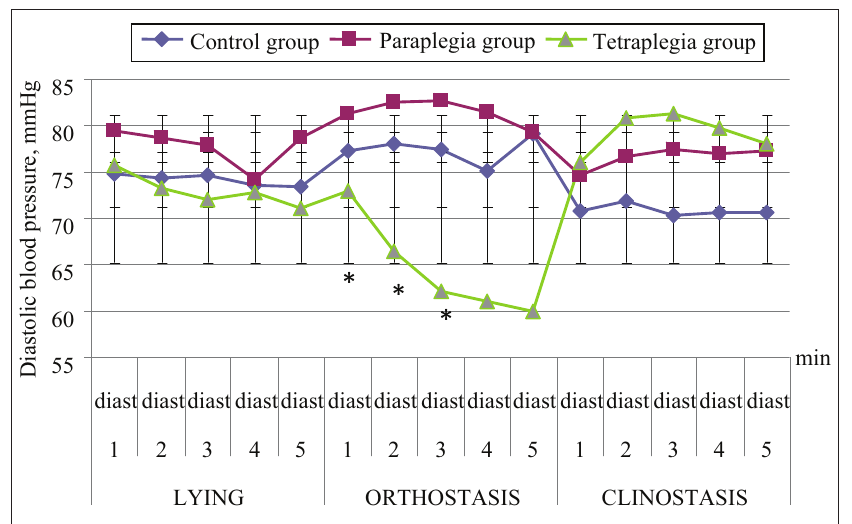
Note. * – Statistically significant difference between all three groups (p <